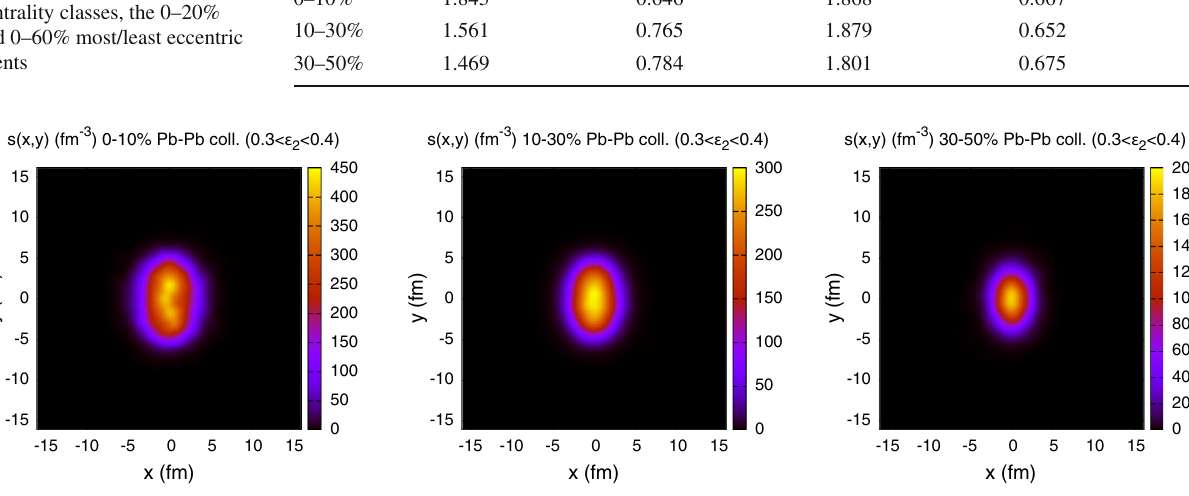
Fig. 7 The initial entropy-density for Pb–Pb collisions at